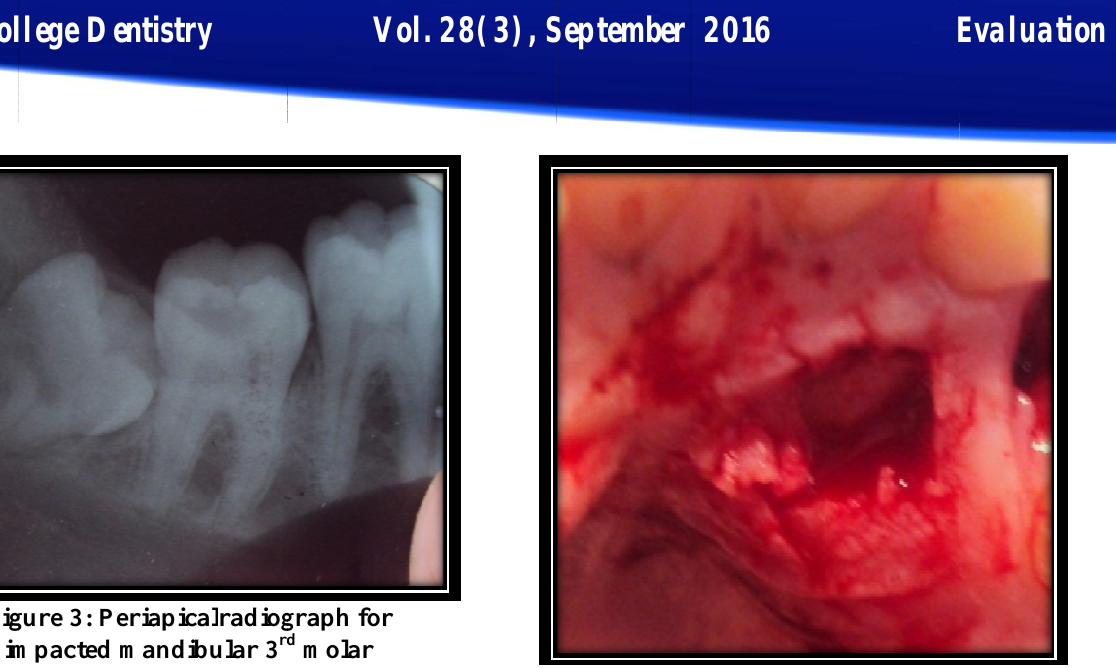
Figure 6: : Maxillary canine exposure In case of a In case of apicoectomy, usedthrough labial approach. through labial approach.